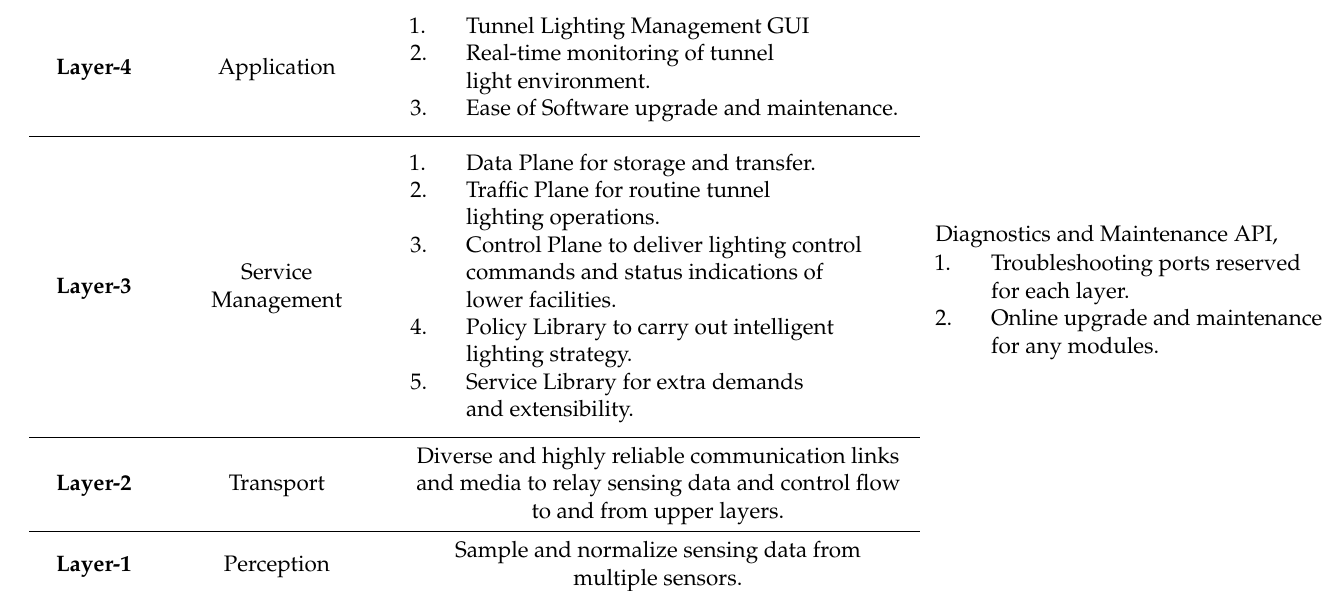
Table 5. System layering and assignment of system